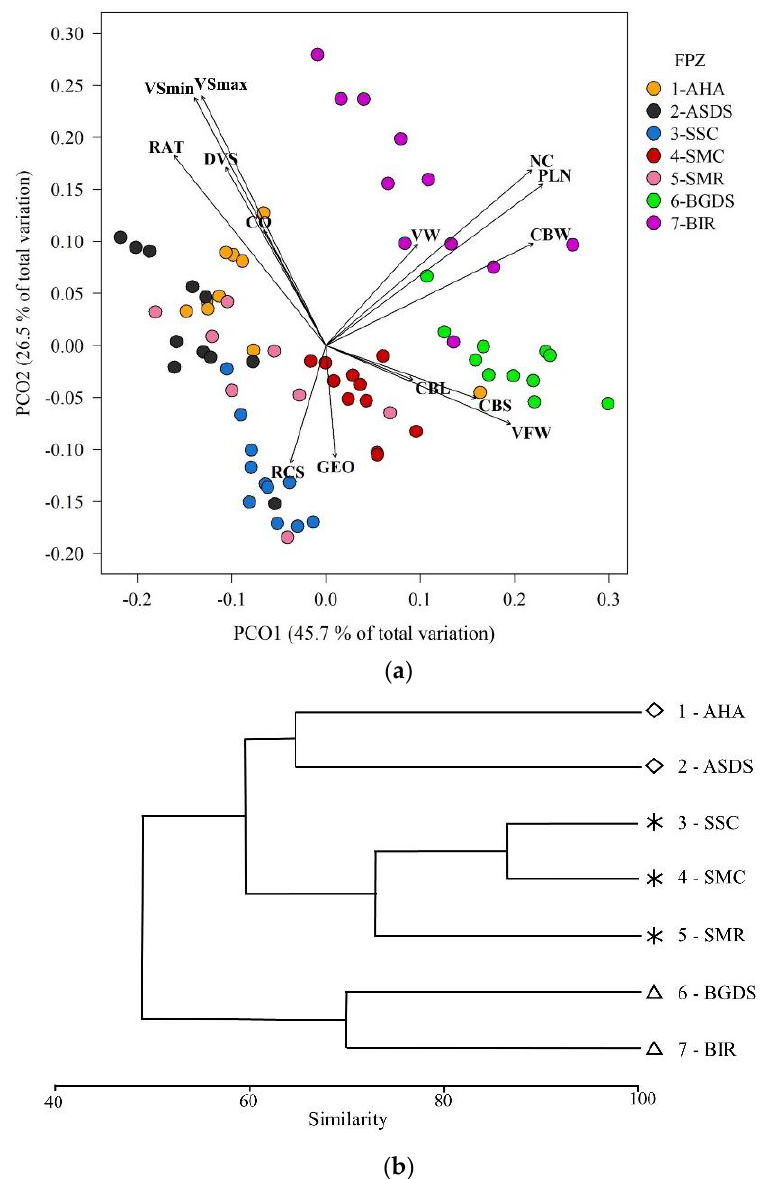
Figure 2. ( a ) Principal coordinate analysis (PCO) diagram showing the position of the riverine FPZs in relation to the geomorphic variables. ( b ) Cluster of the seven FPZs showing similarity at 60%. See variable abbreviations in Table 2.